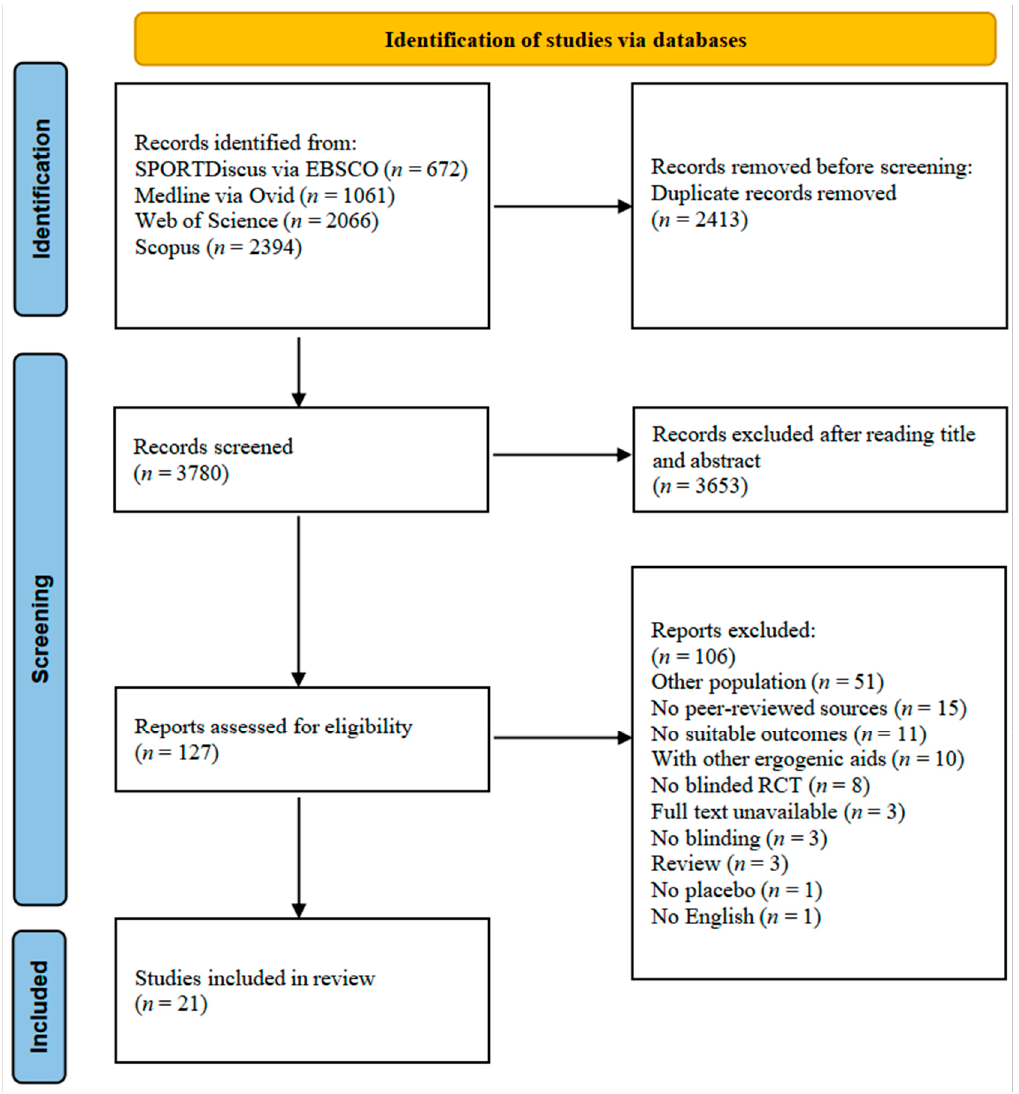
Figure 1. Flow diagram of literature search according to the PRISMA 2020 statement.